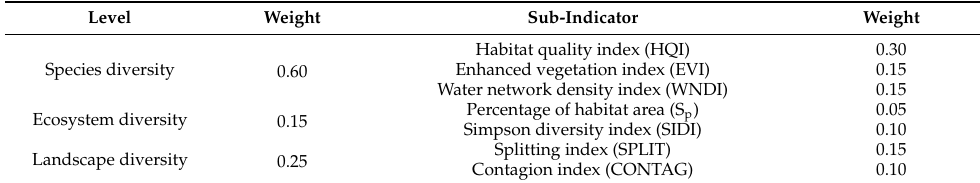
Table 2. Weight and sub-indicator system of BI.